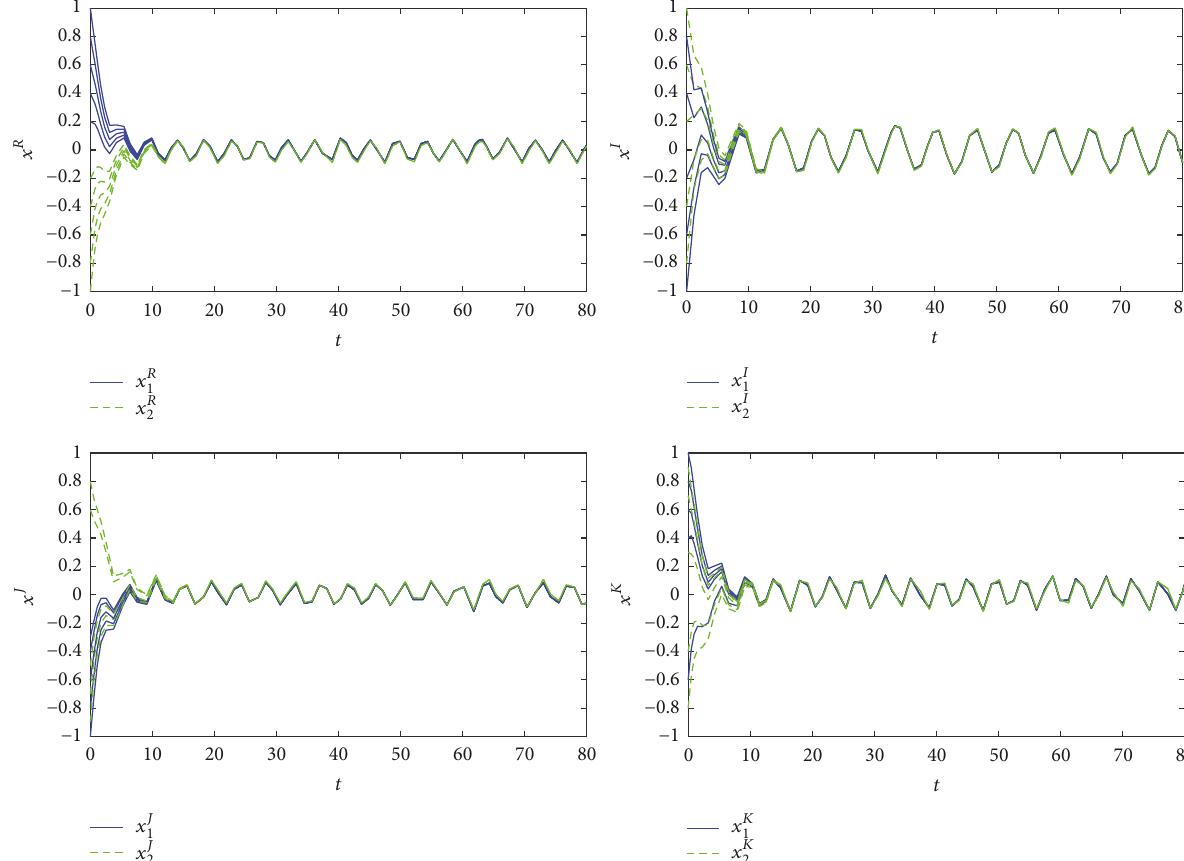
Figure 1: Transient states of four parts with continuous time 𝑡 of (58) in Example